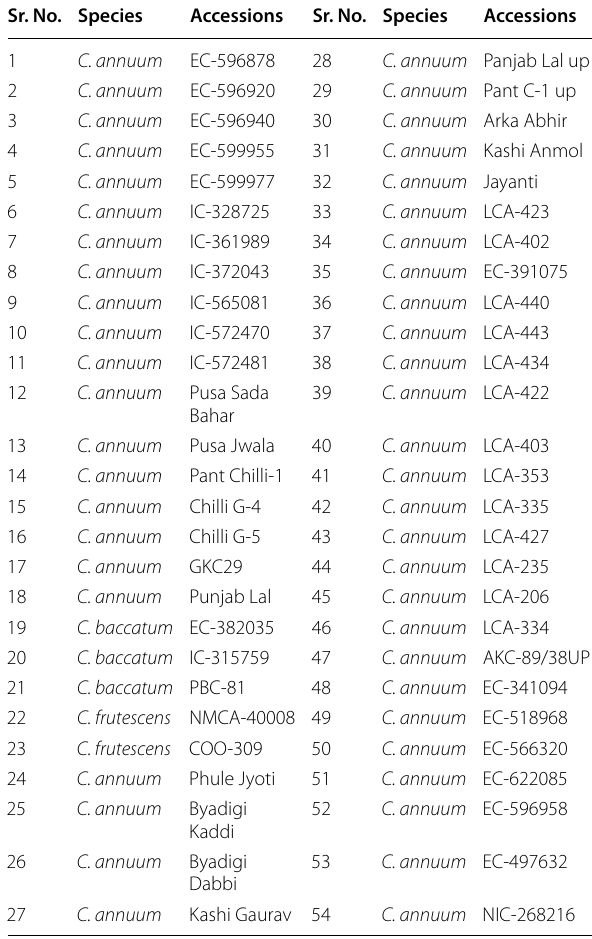
Table 1 Capsicum accessions used for the genetic assessment study Sr. No.